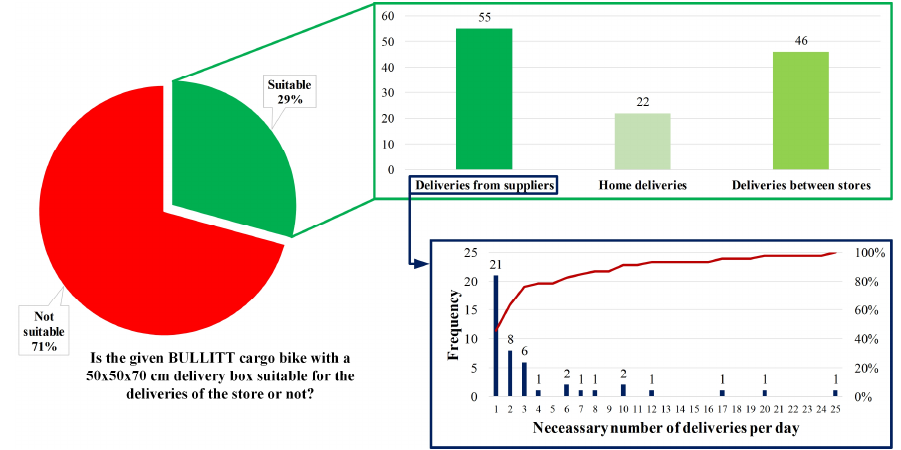
Figure 3. Suitability of a BULLITT cargo bike for different delivery tasks ( N = 375).